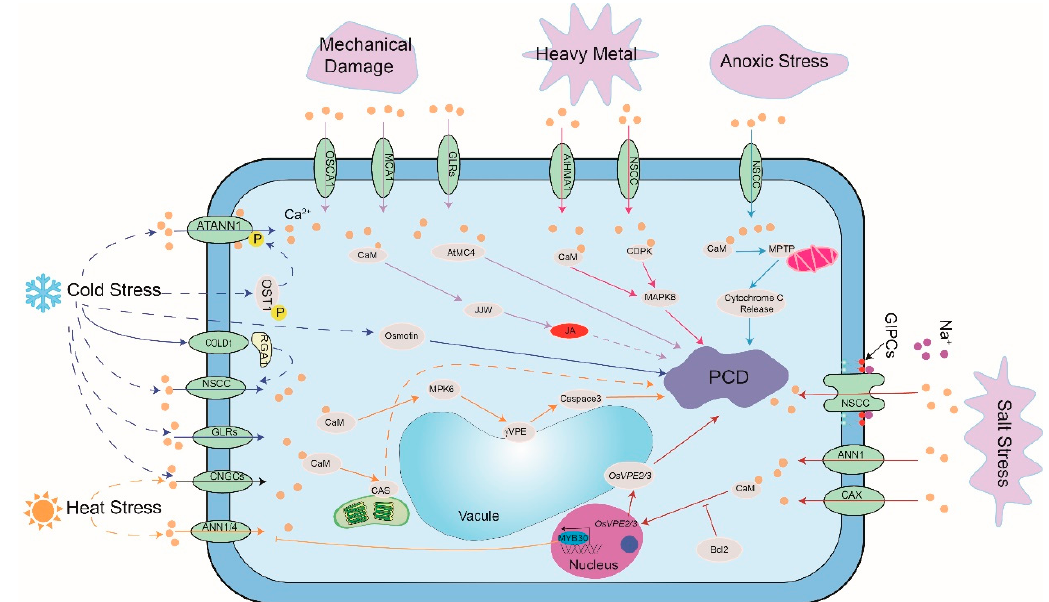
Figure 2. The role of calcium signal in abiotic stress-induced PCD. Salt, temperature, anoxic, heavy metal and mechanic damage stresses are depicted. OSCA1: hyperosmolality-induced [Ca 2+ ](i) increase 1; MCA1: mechanosensitive channel 1; GLRs: glutamate receptor-like channels; AtHMA1: heavy metal transporting ATPase 1; NSCC: nonselective cation channel; CAX: H + /Ca 2+ antiporters; COLD1: chilling-tolerance divergence 1; AtANN1: Ca 2+ - permeable transporter ANNEXIN1; OST1: open stomata 1; RGA1: rice G-protein a subunit 1; VPE: vacuole processing enzymes; JJW: JAV1-JAZ8-WRKY51 complex; JA: jasmonic acid; GIPCs: glycosyl inositol phosphoryl ceramides (based on